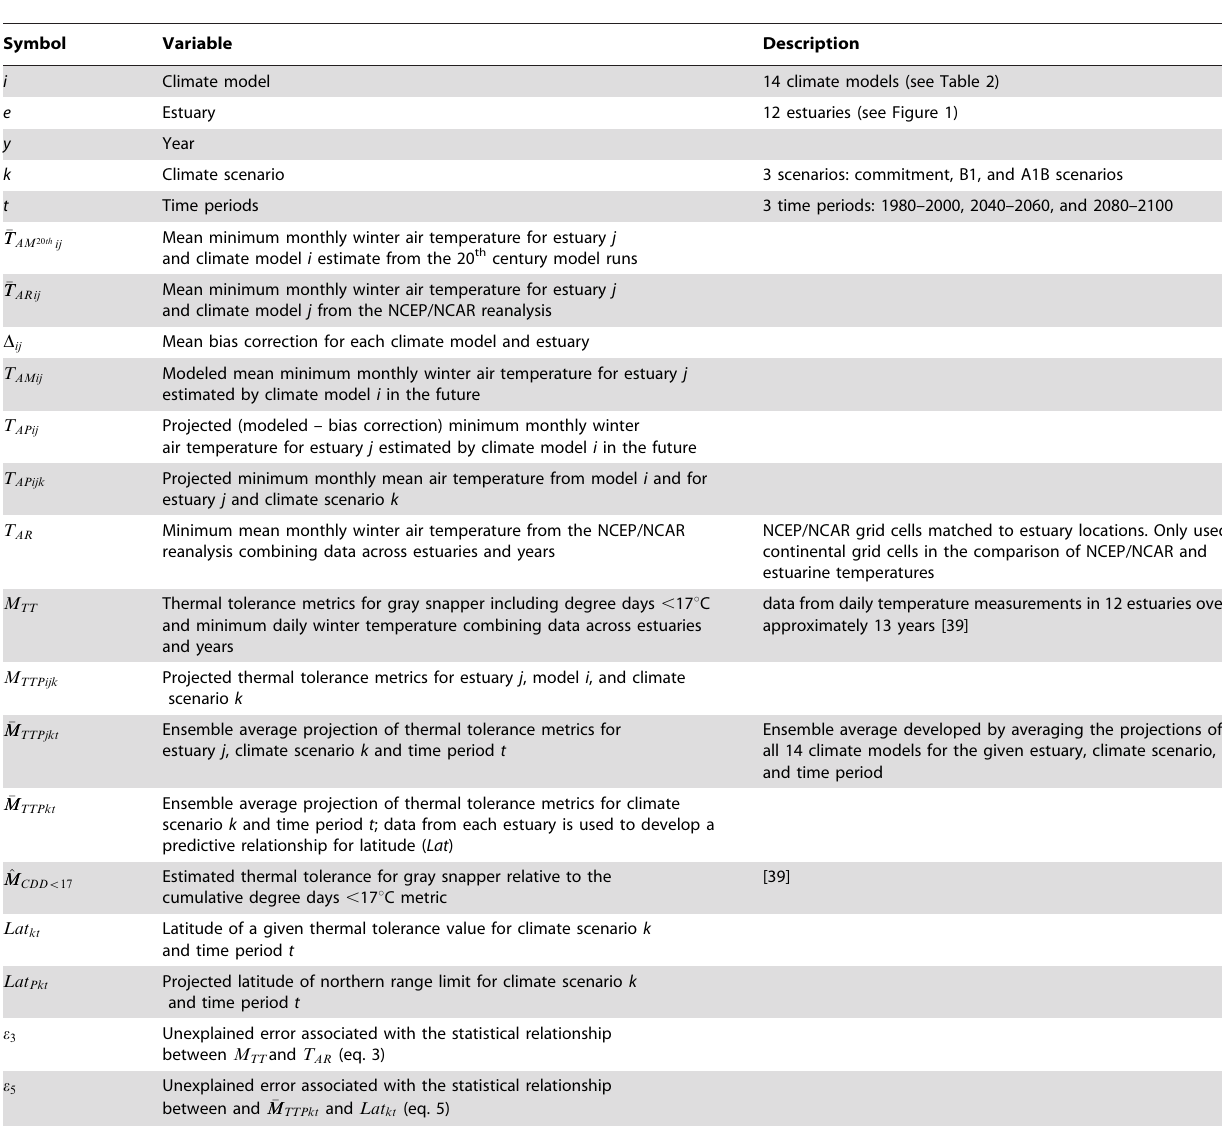
Table 1. Summary of the notation used for variables and equations.